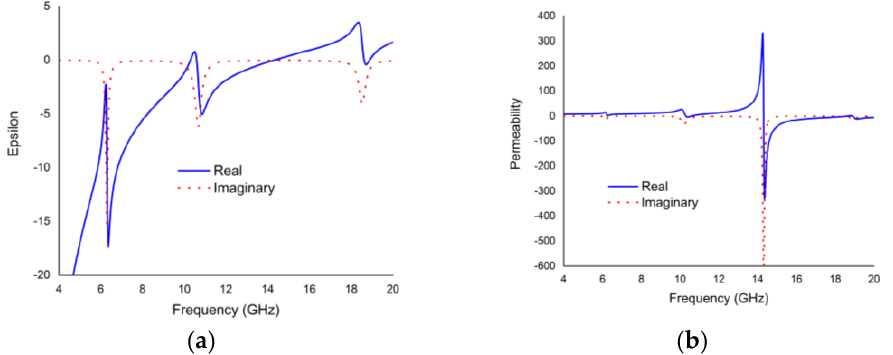
Figure 10. The scenarios of ( a ) permittivity and ( b ) permeability.